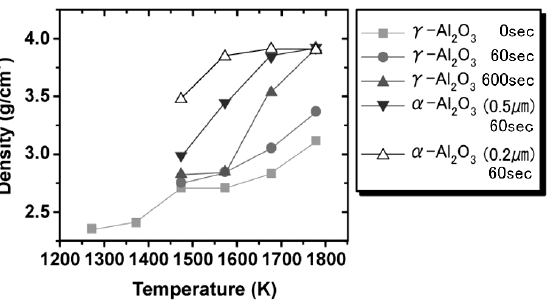
Figure 24. Change of density as a function of temperature under 49 MPa.